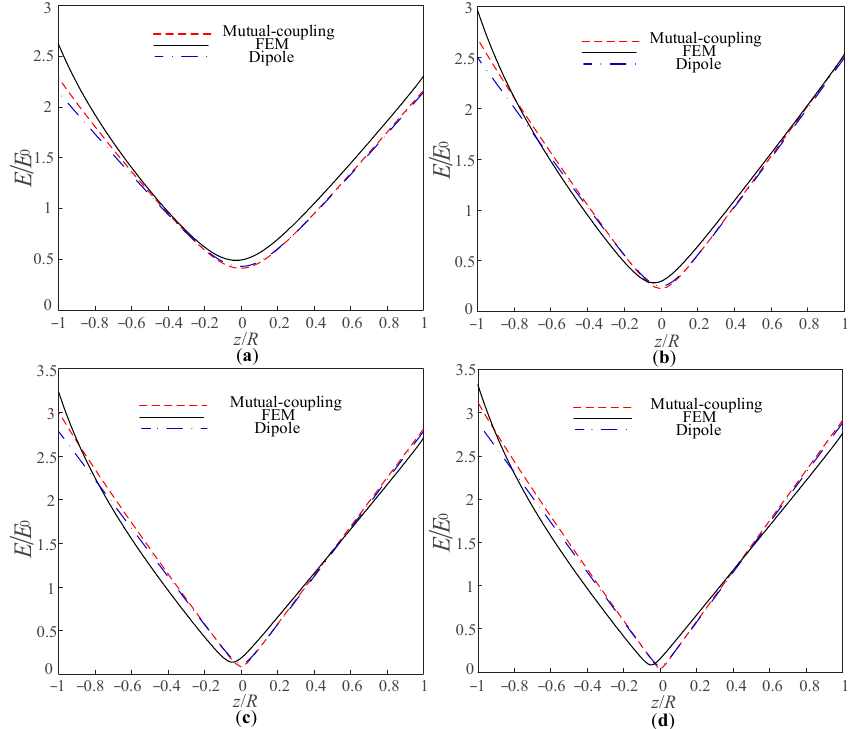
Figure 7. Calculation results of the electric field distribution on particle 1 when D / R = 1: ( a ) Calculation results when ε i / ε e = 5; ( b ) Calculation results when ε i / ε e = 10; ( c ) Calculation results when ε i / ε e = 25; ( d ) Calculation results when ε i / ε e = 50.